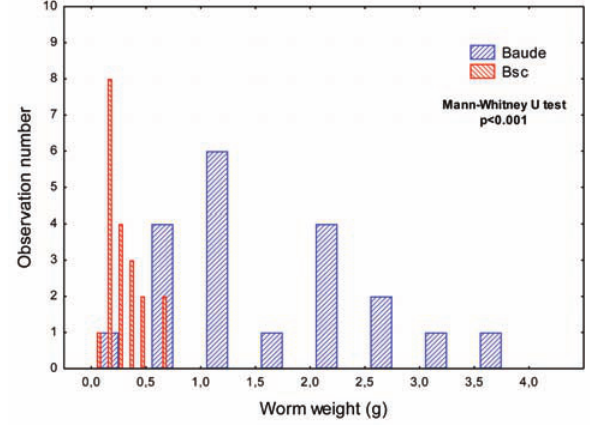
Figure 1. Saguenay Fjord showing the locations of Nereis sp. col- lection sites. BSC, Baie Ste-Catherine (pollution-impacted site); BMB, Baie du Moulin à Baude (reference site).